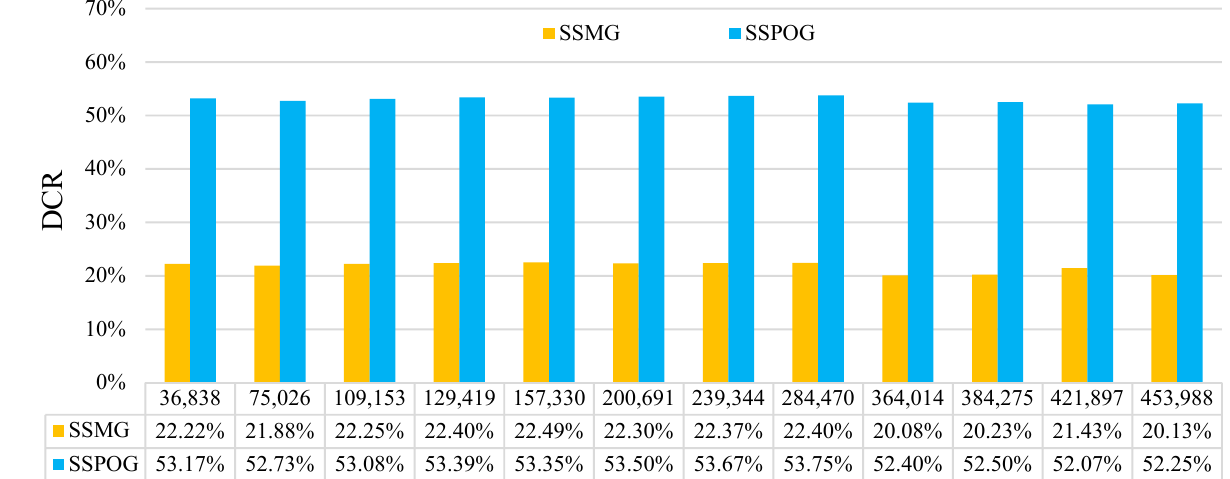
Figure 7. Relationship between the time consumption of geochemical data storage and number of features based on SSMG and SSPOG.